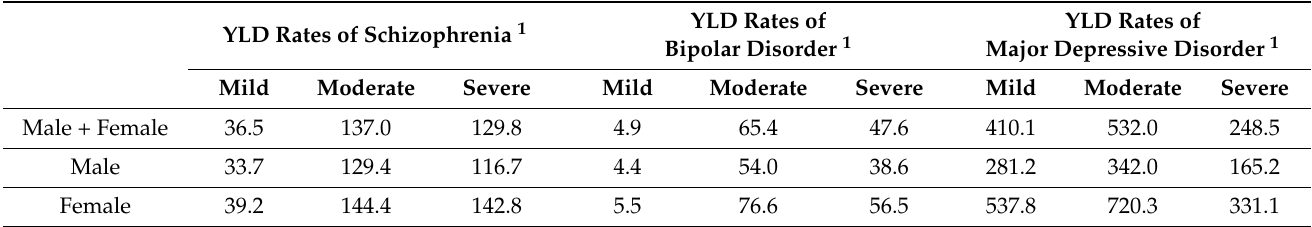
Table 4. YLD rates in Korea attributable to the severity of major psychiatric disease according to